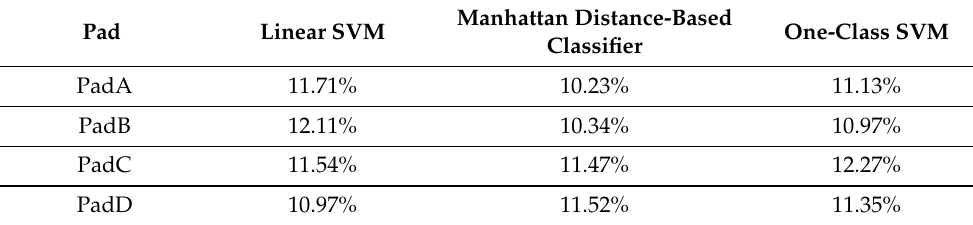
Table 6. EER for removal of the lower 30%